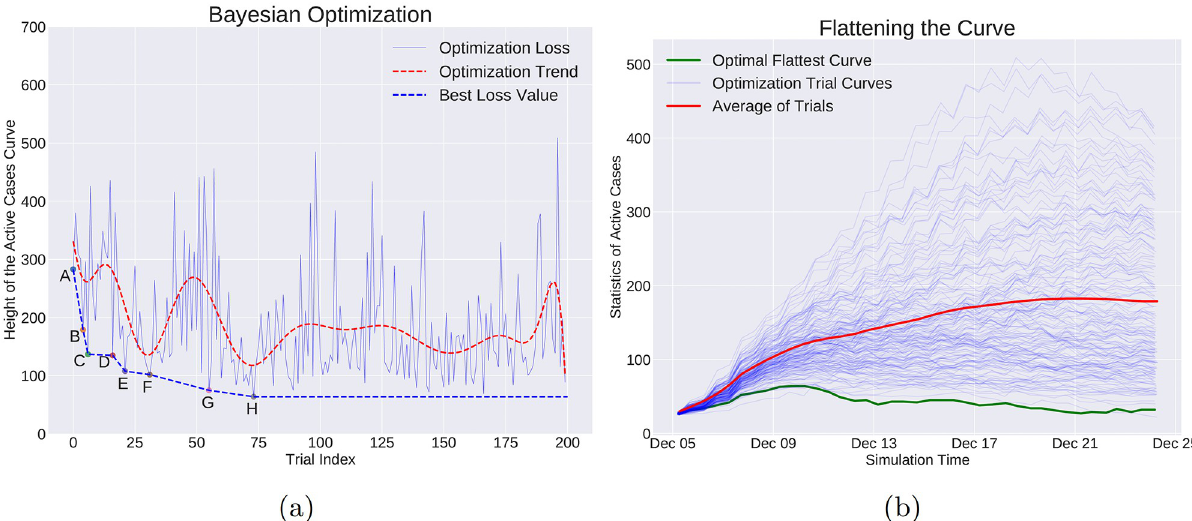
highest spreading potential, imposing the maximum possible restriction on these groups is not the most effective policy. Instead, and in light of the economic constraint α + β + γ = 1.4, the algorithm learns to restrict 60% of the population of students and workers and leave the other 20% of the restriction budget for customers. This solution is relatively counter-intuitive, which emphasizes the benefit of Pyfectious to find control strategies that might be difficult to find by human experts.